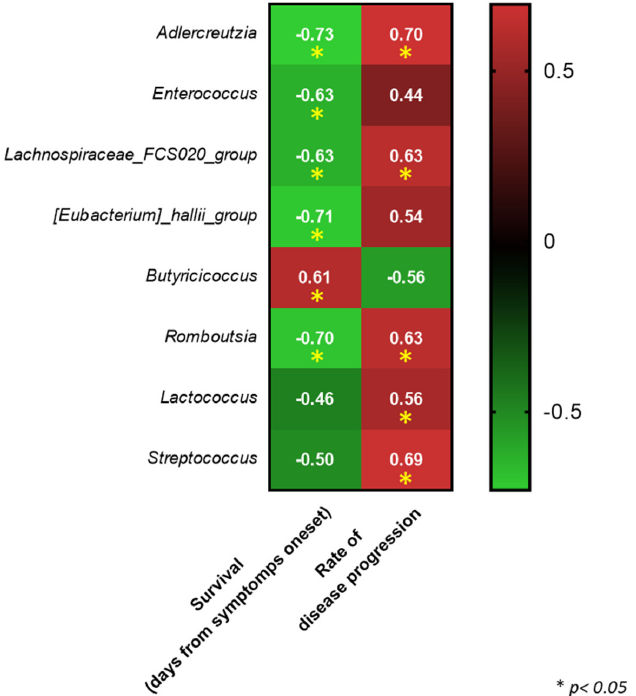
Figure 6. Heatmap of significant correlations (Spearman) identified between taxa relative abundances and disease progression or ALS patients’ survival (days) from symptom onset. Results revealed that controls and ALS patients were characterized by different cor- relation profiles, with the controls including many genera negatively correlated with Pro- pionic acid, and the ALS patients including some genera positively correlated with Acetic acid (Figure 6). Few genera simultaneously showed significant correlations in both con- trols and ALS patient study groups, including the Granulicatella , Lachnospi- raceae _NK4A136_group, Coprobacillus and Ruminococcus gauvreauii group, among which the Granulicatella and Lachnospiraceae _NK4A136_groups showed a consistent positive and negative correlation, respectively, with Propionic acid (Figure 7).